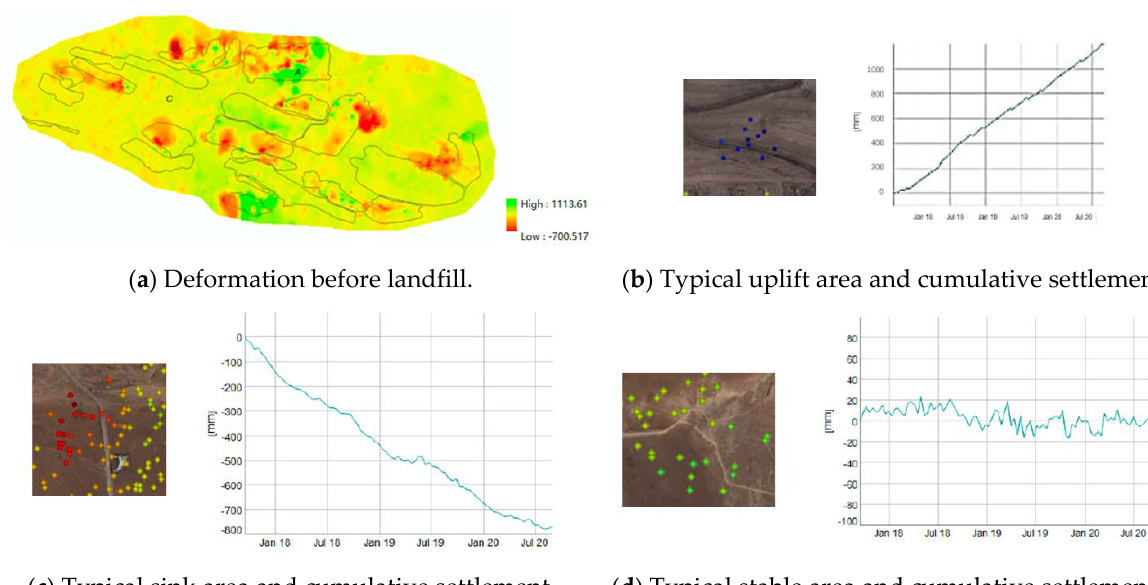
Figure 6. Deformation before landfill and three typical sites in Muli .